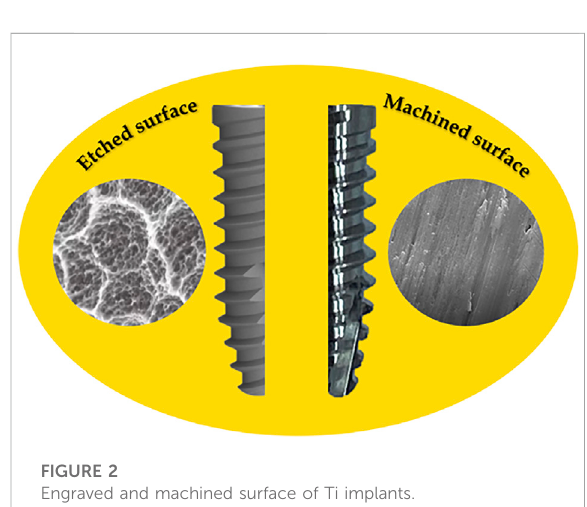
FIGURE 2 Engraved and machined surface of Ti